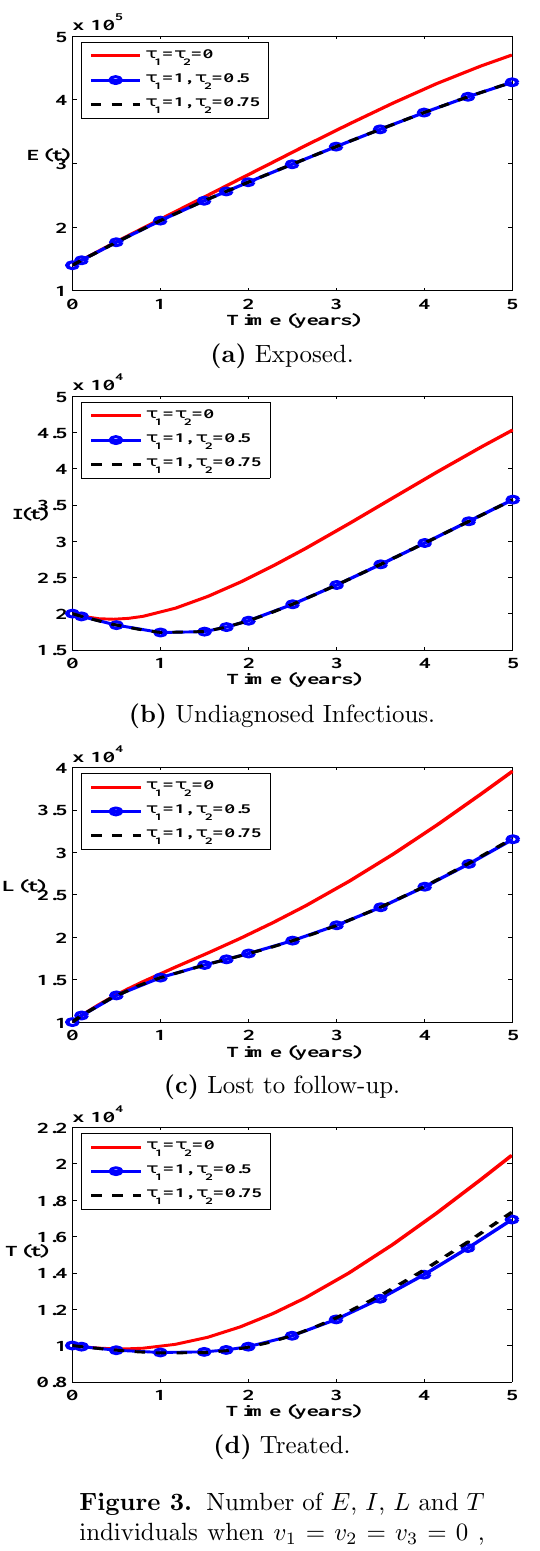
Figure 3. Number of E , I , L and T individuals when v 1 = v 2 = v 3 = 0 , τ 1 = 1 year and time delay τ 2 takes two different values.